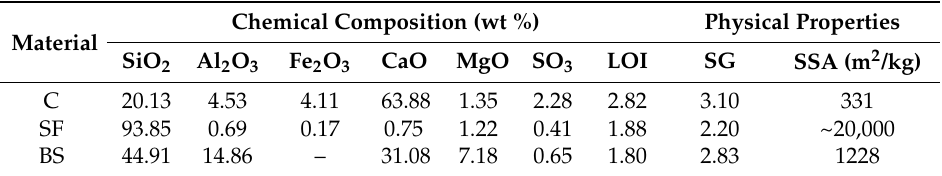
Table 1. Chemical composition and physical properties of cement (C), silica fume (SF), and